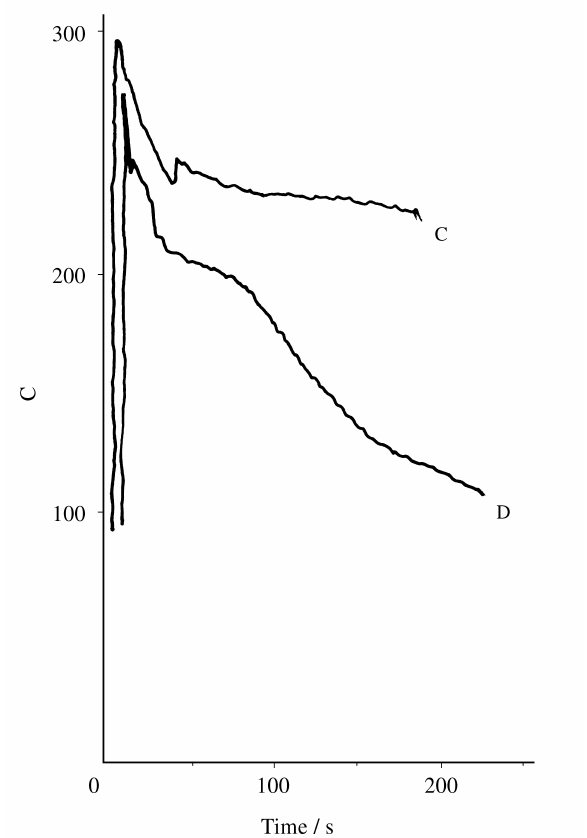
Figure 8. Cooling curves obtained during the solidification of commer- cially pure Sn, with the ‘‘cold-finger’’ technique, with the mold in the vertical downward position and the thermocouple at positions A and B, of the Fig. 7. Both cooling curves show a recalescence that brings the metal temperature above the arrest temperature, as suggested by the MSModel, when the heat extraction is very high (Hypocooling) 9